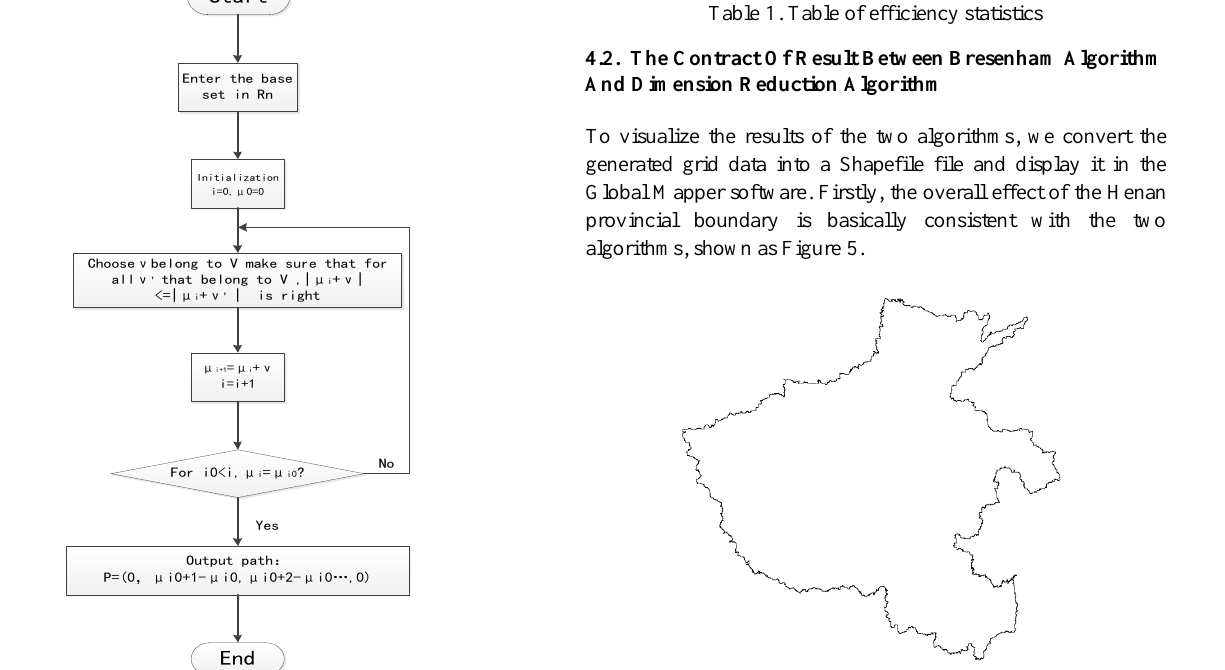
Figure 4. Flow chart of dimension reduction algorithm